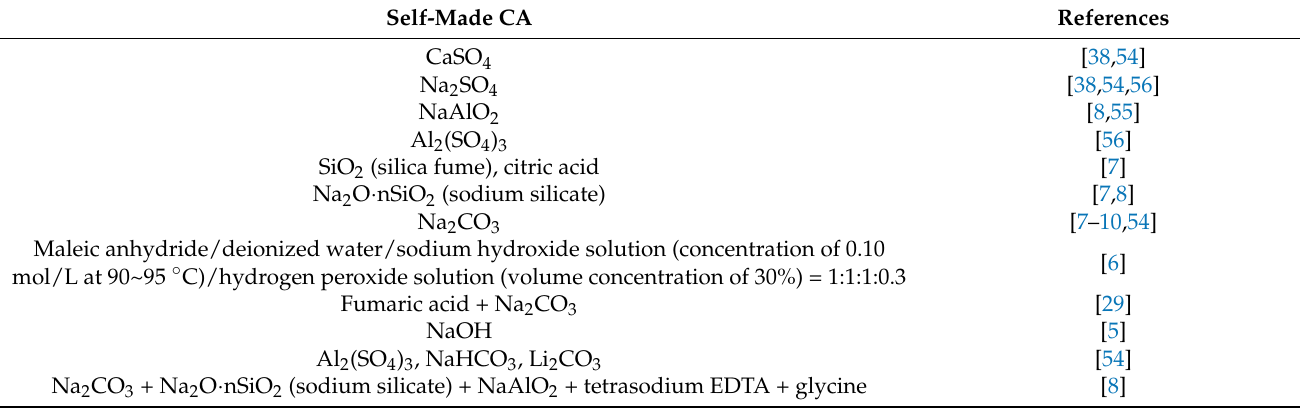
Table 4. The compositions of self-made